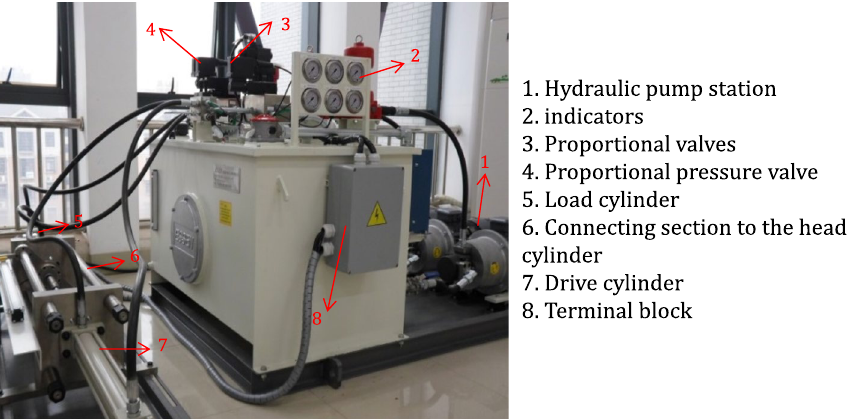
Fig. 6 The experiment structure of the system